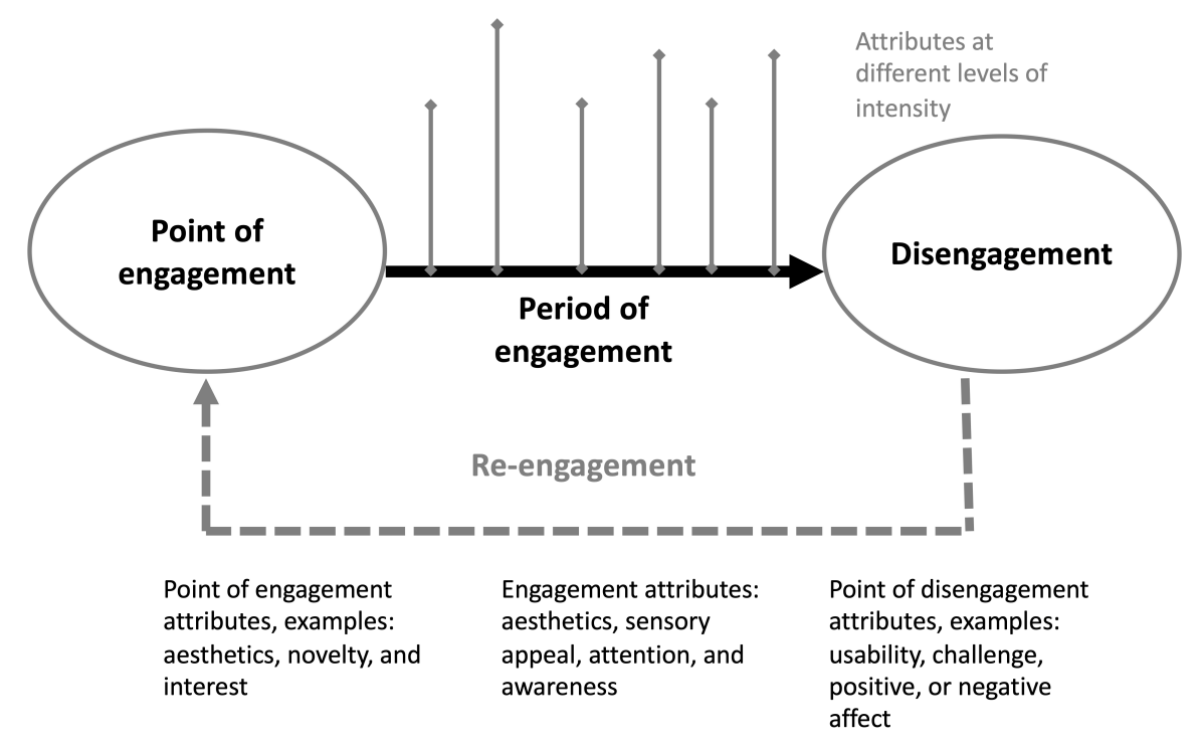
Figure 1. Proposed model of engagement by O'Brien and Toms